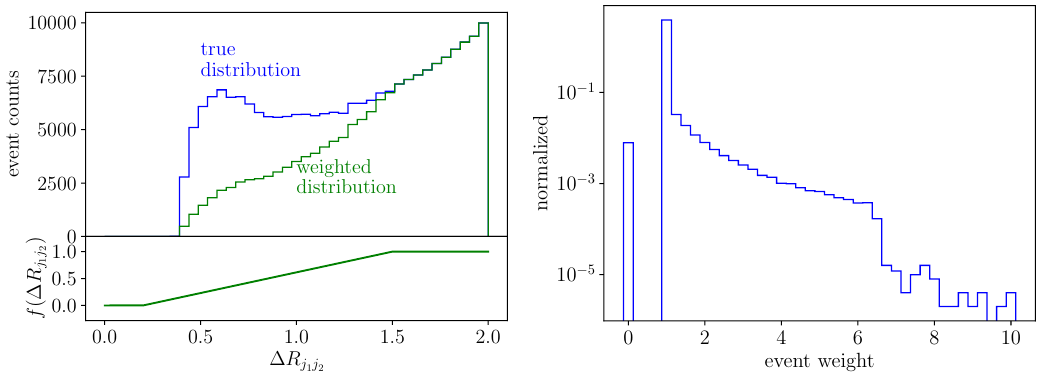
Figure 3: Left: ∆ R -distribution for Z + 2 jets events before and after the transfor- j 1 j 2 mation of Eq.(9). Right: histogram of the weights of the generated